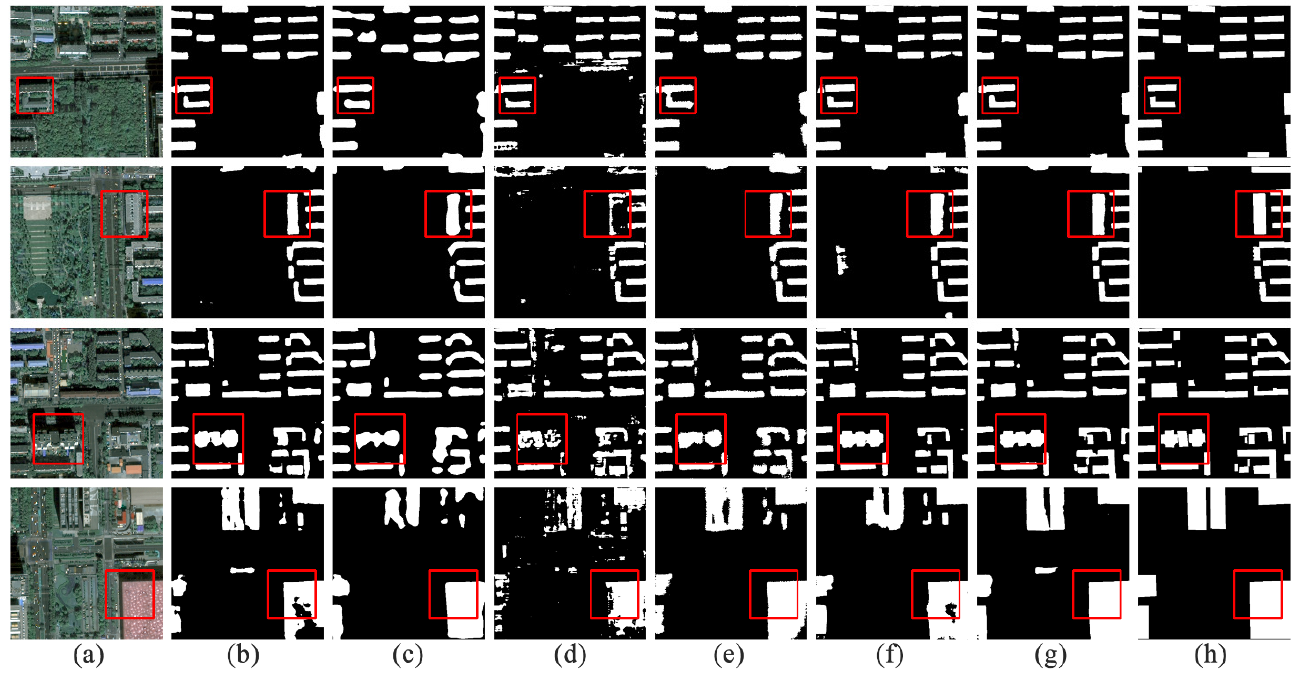
Figure 9. Example of the results with the PSPNet, FCN, DeepLab v3+, SegNet, U-Net, and our proposed method the GF-7 self-annotated building Dataset: ( a ) Original image. ( b ) PSPNet. ( c ) FCN. ( d ) DeepLab v3+. ( e ) SegNet. ( f ) U-Net. ( g ) Proposed model. ( h ) Ground truth.